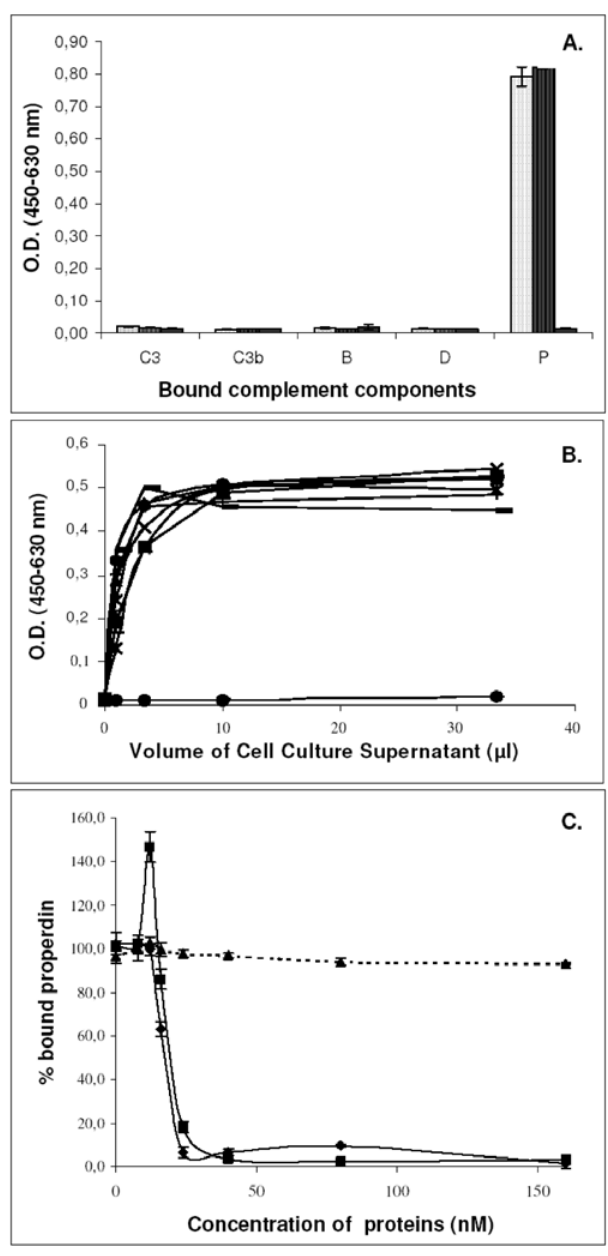
Figure 7. ELISA analysis of the binding of IxAC proteins to immobilized C3 convertase components. Panel A: Binding of IxACs to AP components. Purified recombinant IRAC II, IxAC-B1 or unrelated protein Iris were added to microtiter wells previously coated with purified factors C3, C3b, fB, fD or properdin (P). Bound proteins were detected with an anti-V5 monoclonal antibody using an ELISA format. Light dotted histogram: IRAC II; dark dotted histogram: IxAC-B1; black histogram: Iris. Panel B: Increasing amounts of normalized supernatant from transfected culture 293T cells were added to immobilized properdin. Bound IxACs were detected with an anti-V5 antibody. Black diamond: Iris; black square: IRAC I; black triangle: IRAC II; cross: IxAC-B1; star: IxAC-B2; closed circle: IxAC-B3; plus: IxAC-B4; minus : IxAC-B5. Panel C. Competition between properdin and IxACs for C3b binding. Purified properdin and increasing amounts of IRAC II, IxAC-B1 or unrelated control IRIS were added simultaneously to C3b-precoated microtiter wells. Bound properdin was detected with an anti-properdin monoclo- nal antibody. Black diamond: IRAC II; black square: IxAC-B1; black triangle: Iris. doi:10.1371/journal.pone.0001400.g007 PLoS ONE |